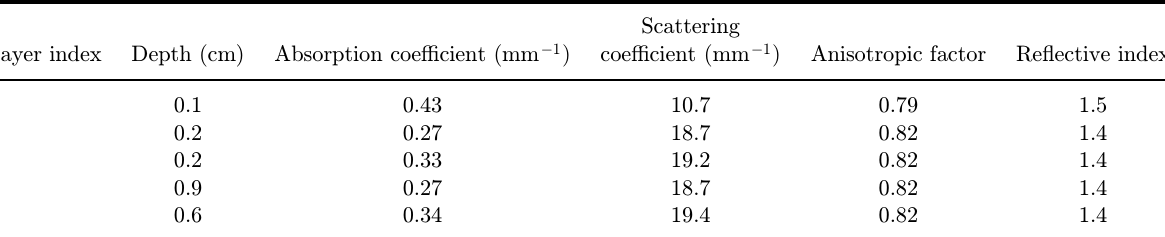
Table 2. Optical properties of the multilayered tissues.